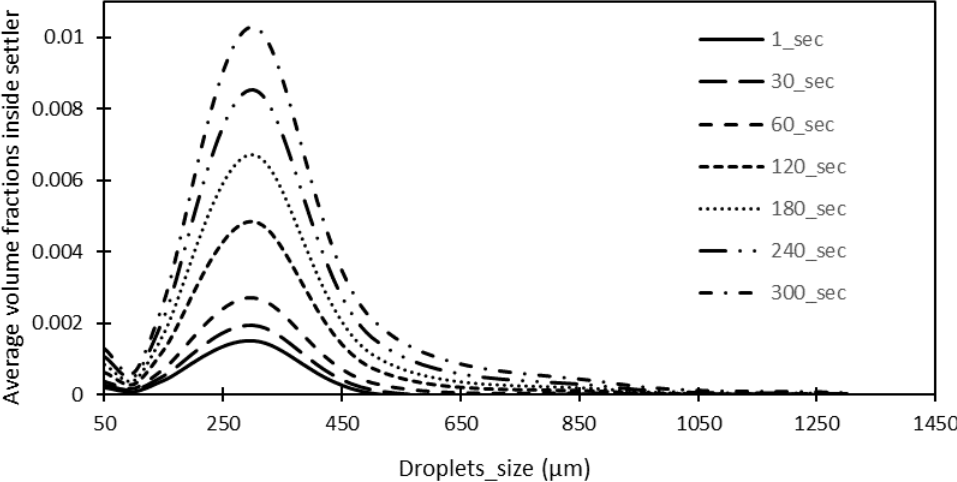
Figure 5. Volume fraction distribution Figure 5 . Volume fraction distribution curves .